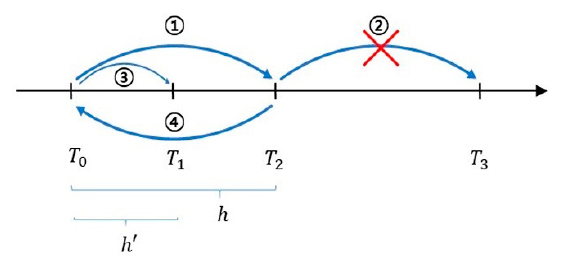
Figure 2. Step revision algorithm with rollback.